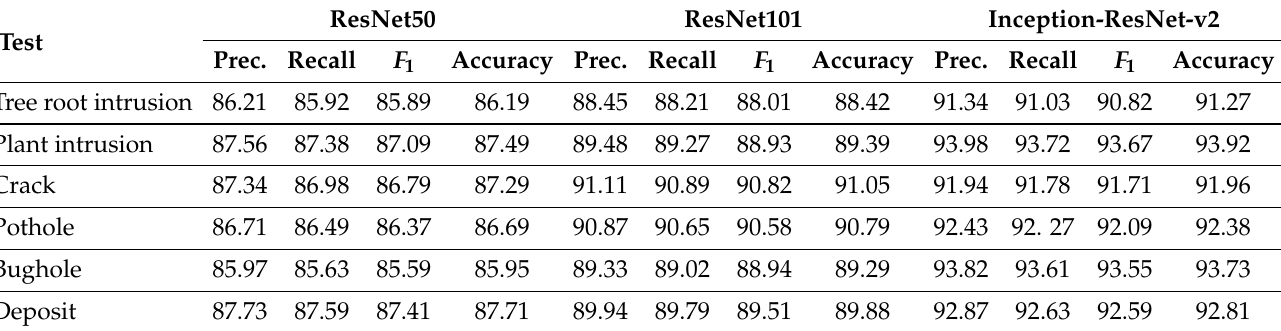
Table 3. Statistical measures for defect